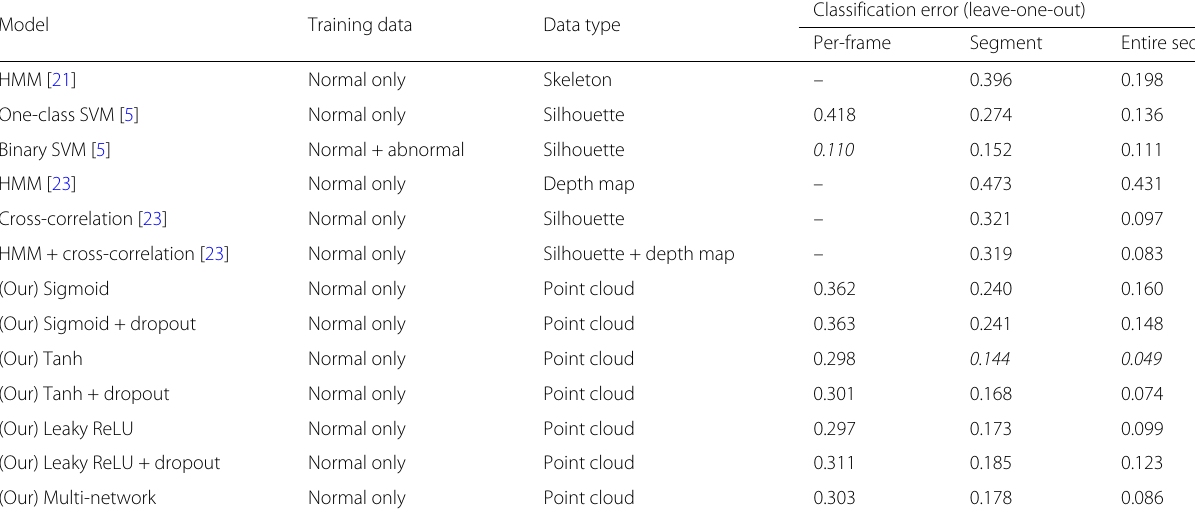
Table 3 Average classification errors ( ≈ EERs) resulting from our leave-one-subject-out cross validation